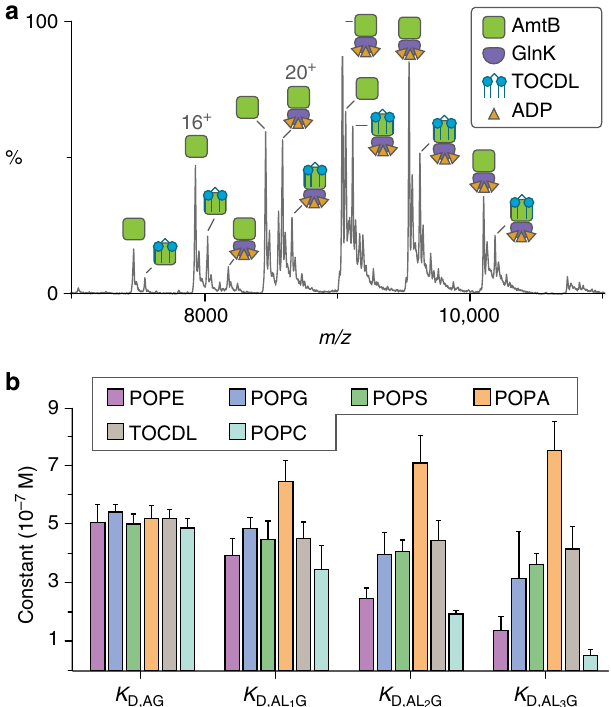
Fig. 2 Native mass spectrometry reveals individual lipid-binding events can allosteric modulate the interaction between GlnK and AmtB. a